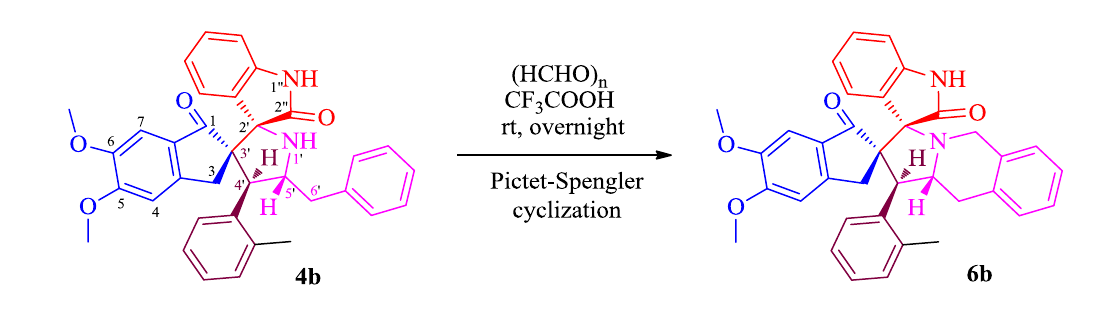
Scheme 2. Plausible mechanism for the formation of spiropyrrolidine 4